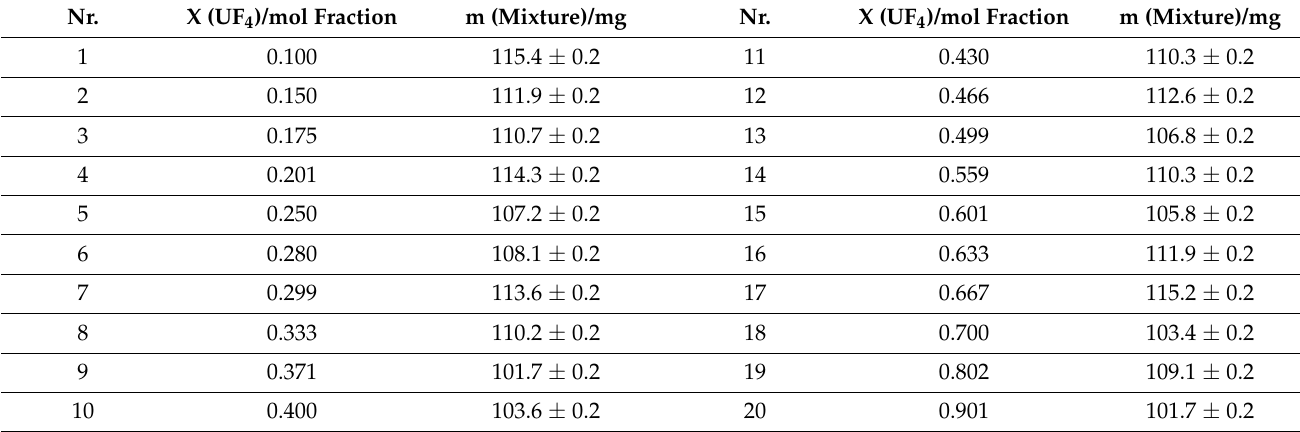
Table 1. Intermediate NaF-UF 4 compositions subjected to DSC measurements within this study. Nr.